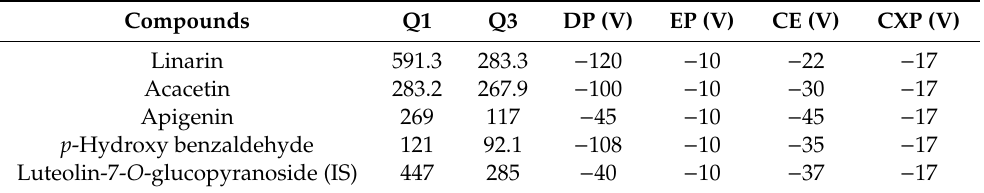
Table 1. Mass scan method parameters of analytes and internal standard (IS). Compounds